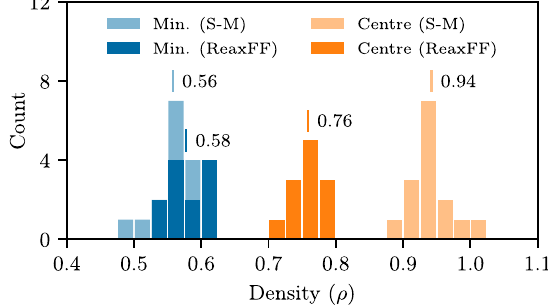
Fig. 11 Histogram of the minimum and mean densities in the junction models. The distribution of minimum and mean densities in junction models deposited on 16 × 16 Å 2 Al(100) substrates with different potentials. The minimum density is the minimum value in the blue shaded regions in Fig. 10. The central density is the mean value of the orange shaded region. As shown in Fig. 10, the minimum densities occur at the Al/AlO x interfaces.